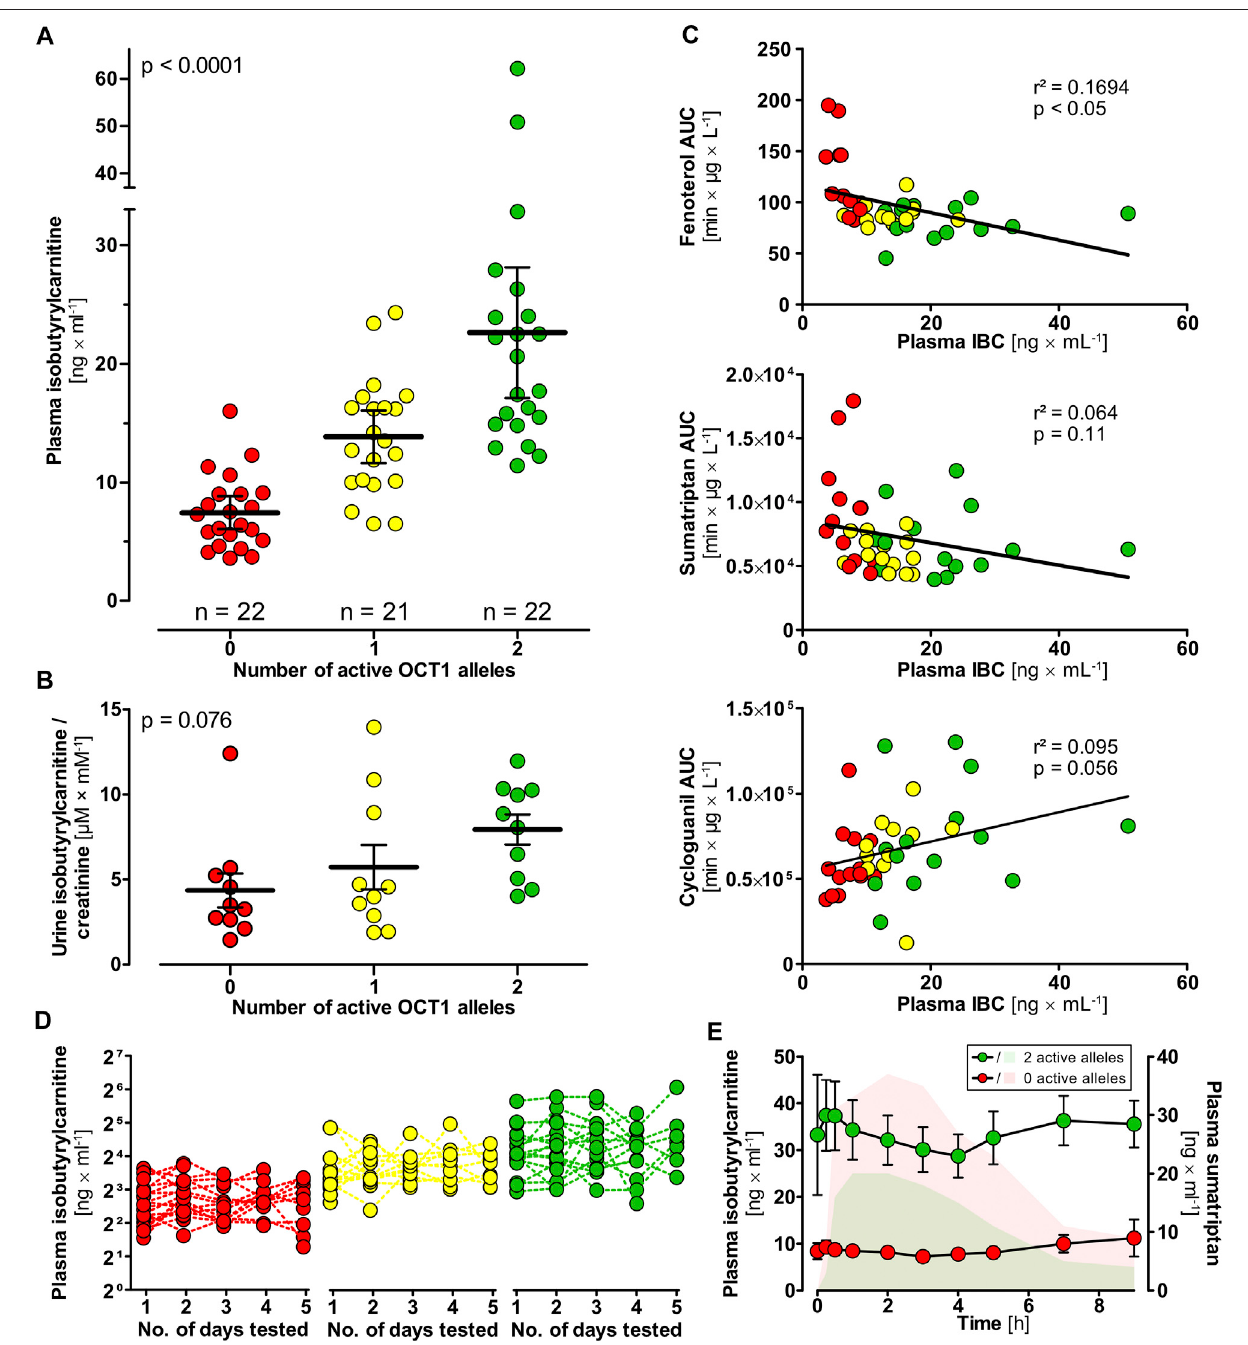
FIGURE 2 | Isobutyrylcarnitine plasma concentrations in healthy volunteers (red circles, 0 active OCT1 alleles; yellow circles, 1 active OCT1 allele; green circles, 2 active OCT1 alleles). (A) HigherIBCplasmaconcentrationscould be observedin individuals withactive OCT1 compared toOCT1-de fi cient individuals(statistical testing performed using one-way ANOVA). (B) IBC urine concentrations were higher in individuals with active OCT1 compared with de fi cient OCT1 as well, however, not statistically signi fi cant ( p (cid:2) 0.076, linear regression analysis). (C) Mean IBC plasma concentrations showed genotype-dependent correlation with AUCs of the knownOCT1substratesfenoterol,sumatriptan,andcycloguanil(linearregressionstatistics). (D) HighinterindividualbutlowintraindividualvariationinofplasmaIBCwas foundsupportingastronggeneticbackgroundforhumanplasmaIBC. (E) IBCplasmaconcentrations(circles)afterasingleoraldoseof50 mgsumatriptan.Sumatriptan plasma concentrations of individuals with two reference alleles (green AUC) and individuals with zero active alleles are indicated. This data indicates that the IBC-OCT1 correlation is not only mediated by OCT1 genotype but also be OCT1 activity. Data are represented as the mean ± SEM.